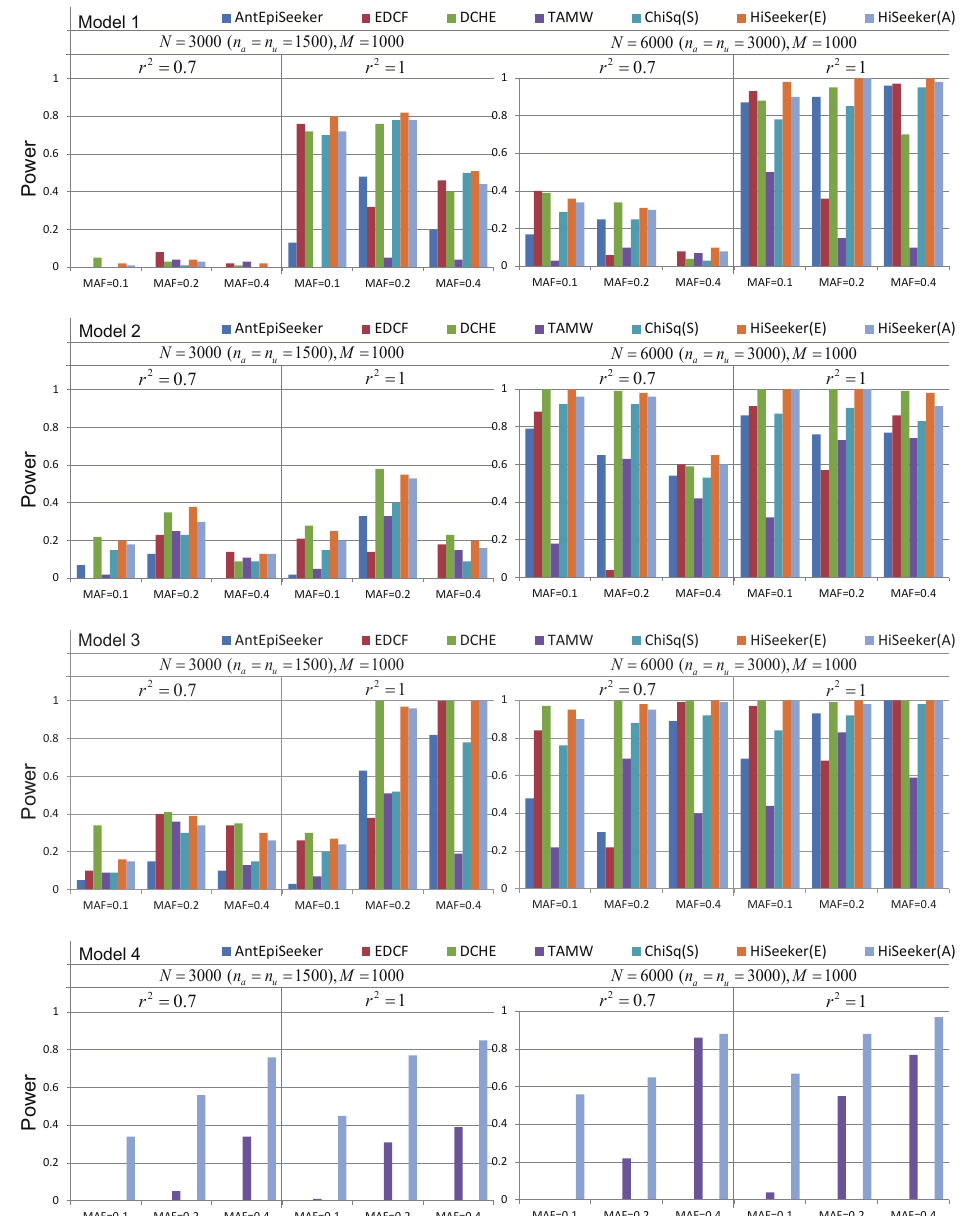
Figure 4. Powers of AntEpiSeeker, EDCF, DCHE, TAMW, ChiSq(S), HiSeeker(E) and HiSeeker(A) on four disease models with different allele frequencies and sample sizes. n a and n u denote the number of cases and controls, respectively. The absence of a bar indicates no